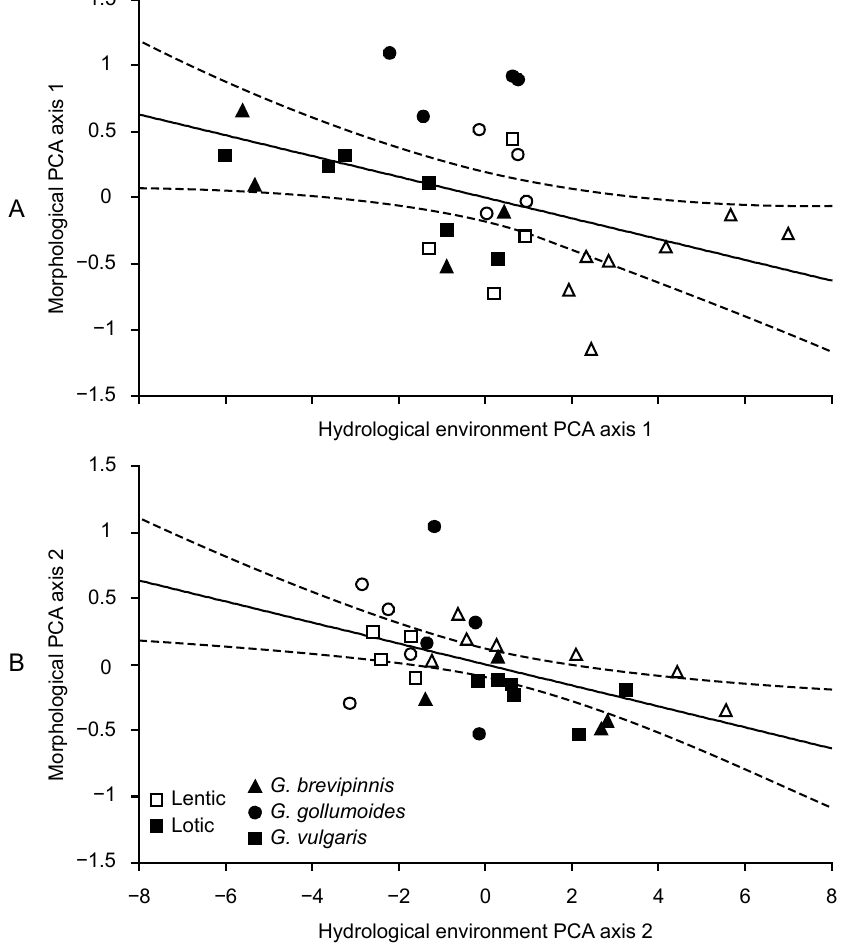
Figure 6. Spearman ρ rank correlations between hydrological environment principle component analysis (PCA) and morphological PCA: A—axis 1; and B—axis 2 scores; suggesting morphological convergence of G. brevipinnis , G. gollumoides and G. vulgaris morphologies in similar hydrological environments. Both correlations were significant at p < 0.05.